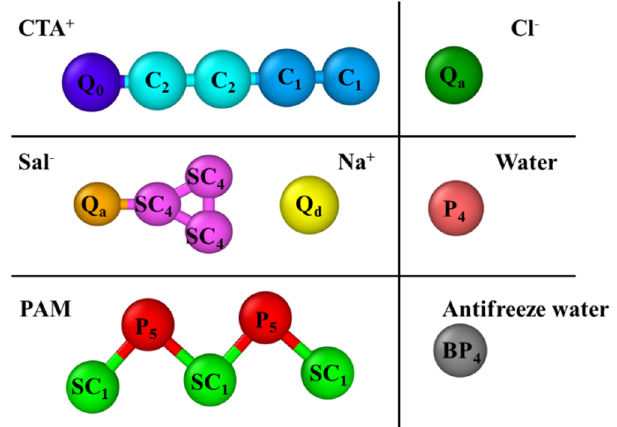
Figure 1. Mapping of cetyltrimethyl ammonium chloride (CTAC), polyacrylamide (PAM), sodium salicylate (NaSal) water, and antifreeze water in the MARTINI coarse-grained model.